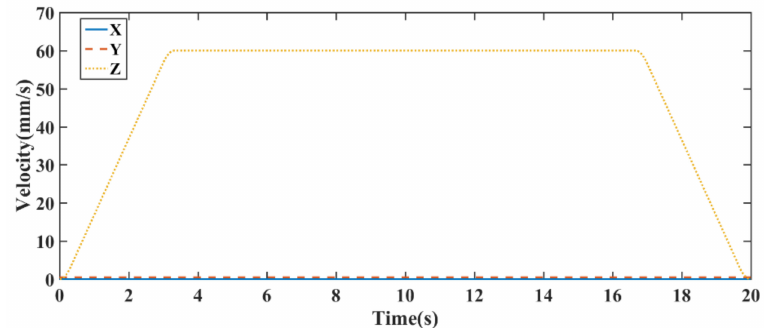
Figure 17. Velocity curve of the end effector.